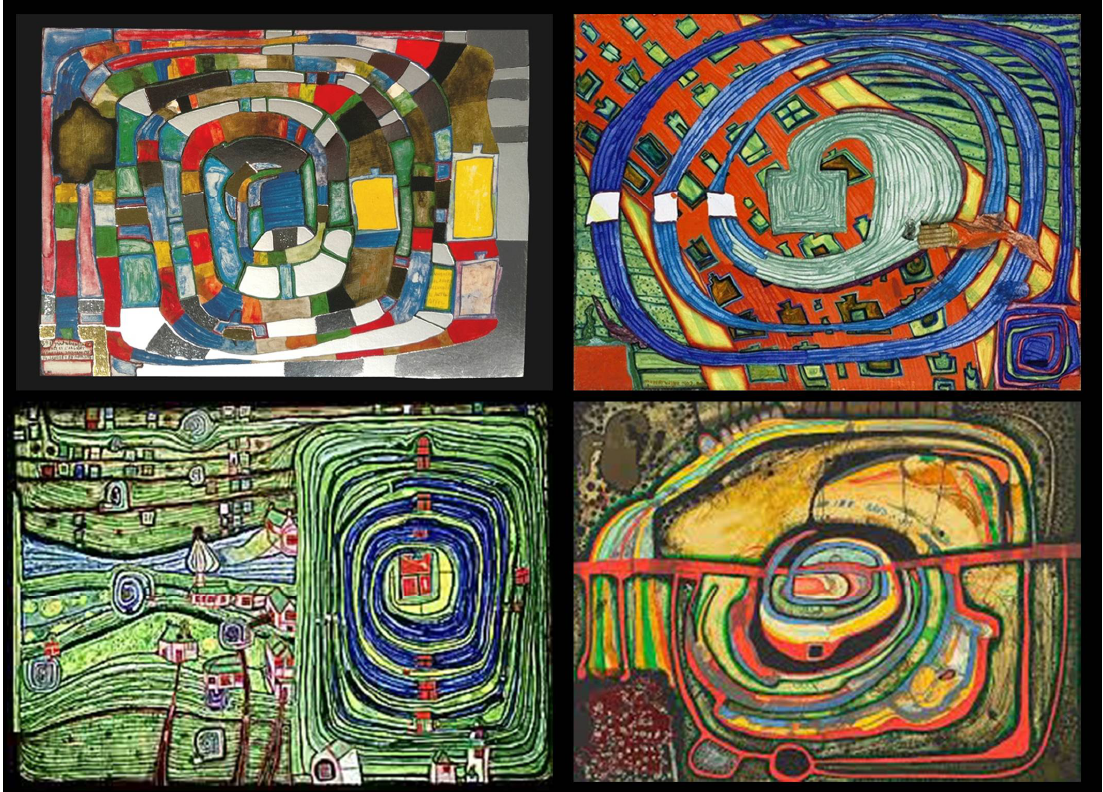
Figure 3. Hundertwasser’s spiral